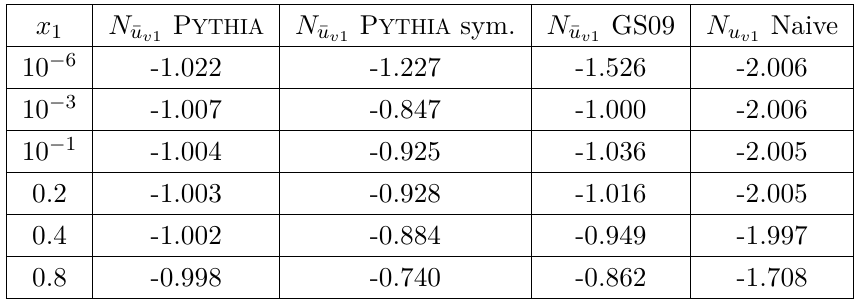
( x 1 , x 2 , Q ) response function at fixed u ¯ u